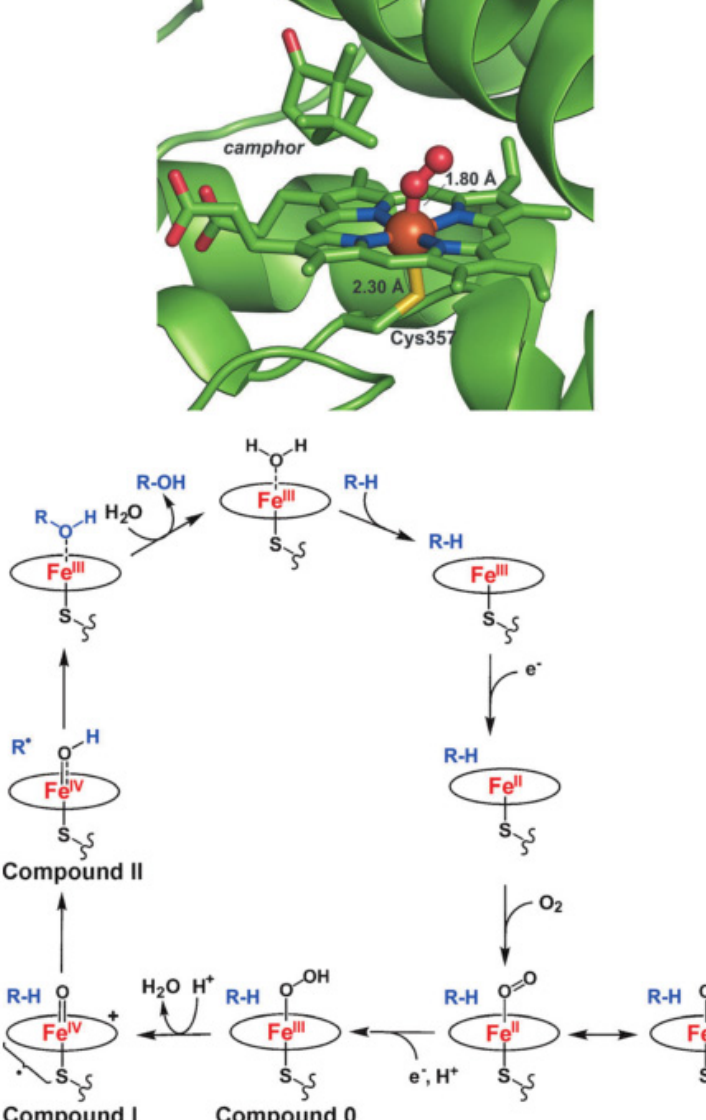
Figure 1. O 2 bound to the ferrous heme in the active site of cytochrome P450 ( top ); the catalytic cycle of cytochrome P450 ( bottom ). Reprinted with permission from Ref. [9]. Copyright 2014, WILEY-VCH Verlag GmbH.